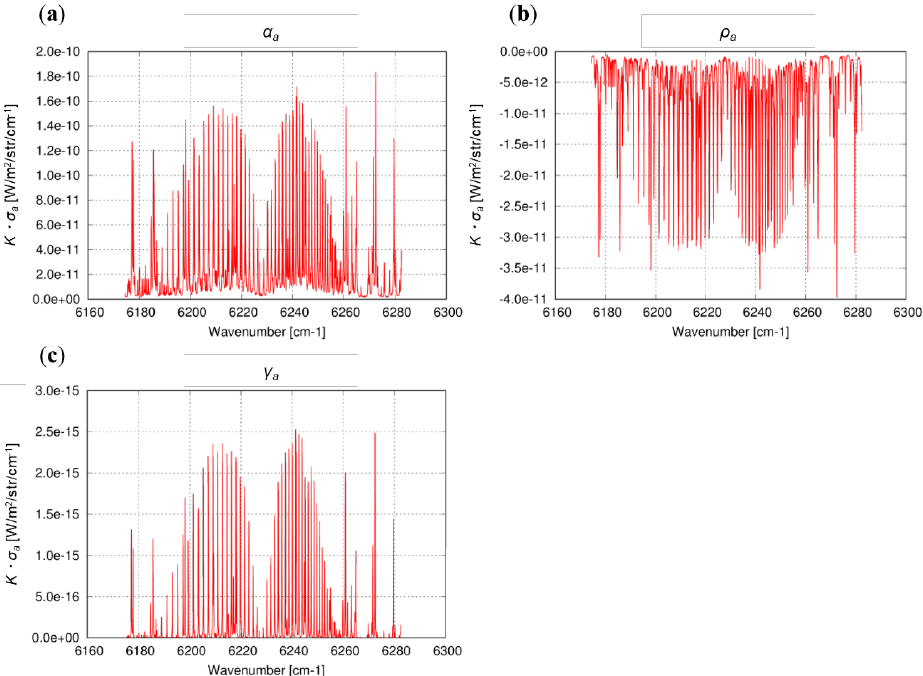
Figure 2. Radiance spectrum of the K · σ a for α a ( a ), ρ a ( b ), and γ a ( c ) in Band 2.